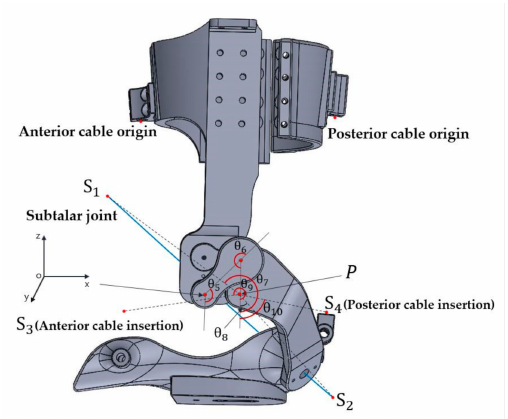
Figure 4. 2DoF ankle exoskeleton showing the location of the cable origin, the insertion points, and the subtalar